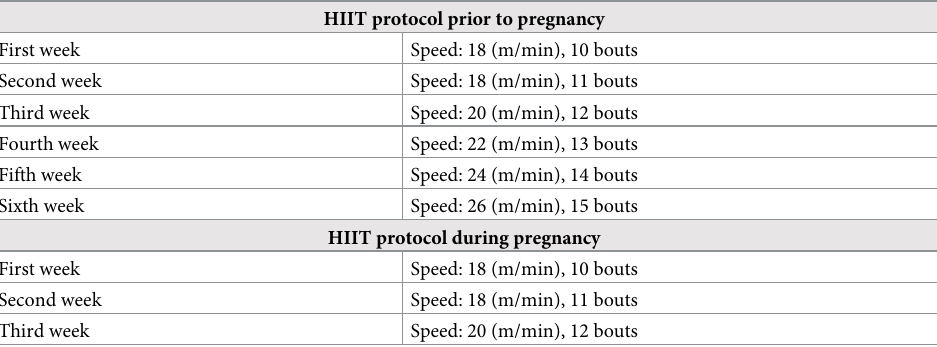
Table 1. Characteristic of HIIT protocol prior to and during